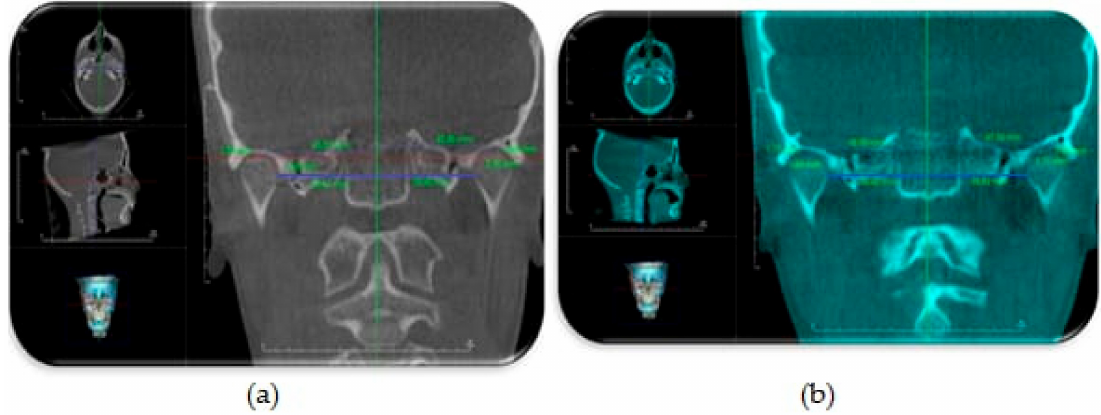
Figure 6. CBCT coronal generated view showing assessment of condylar head position relative to MSP (green line): ( a ) before TB therapy; ( b ) after TB